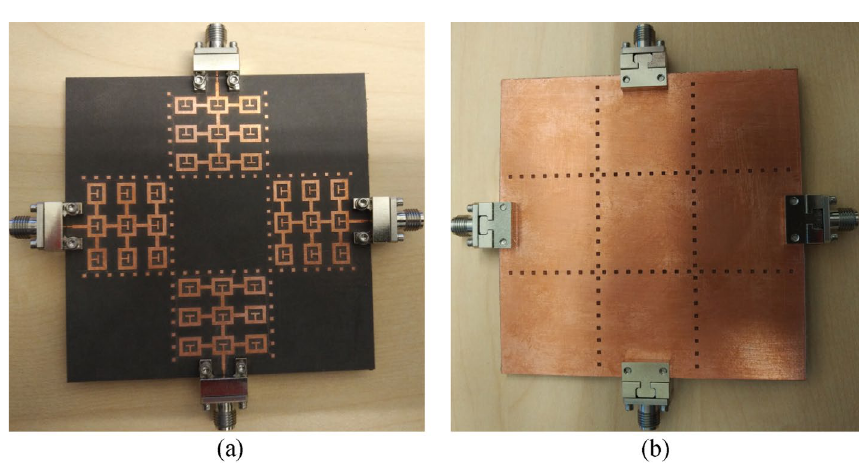
Figure 7. Fabricated prototype of the proposed four-element antenna array, ( a ) top side showing each square resonant ring is loaded with a T-shaped matching stub and each radiating element is enclosed within the isolating dot-walls, and ( b ) bottom side showing the defected ground plane loaded with square shaped slots that are aligned underneath the